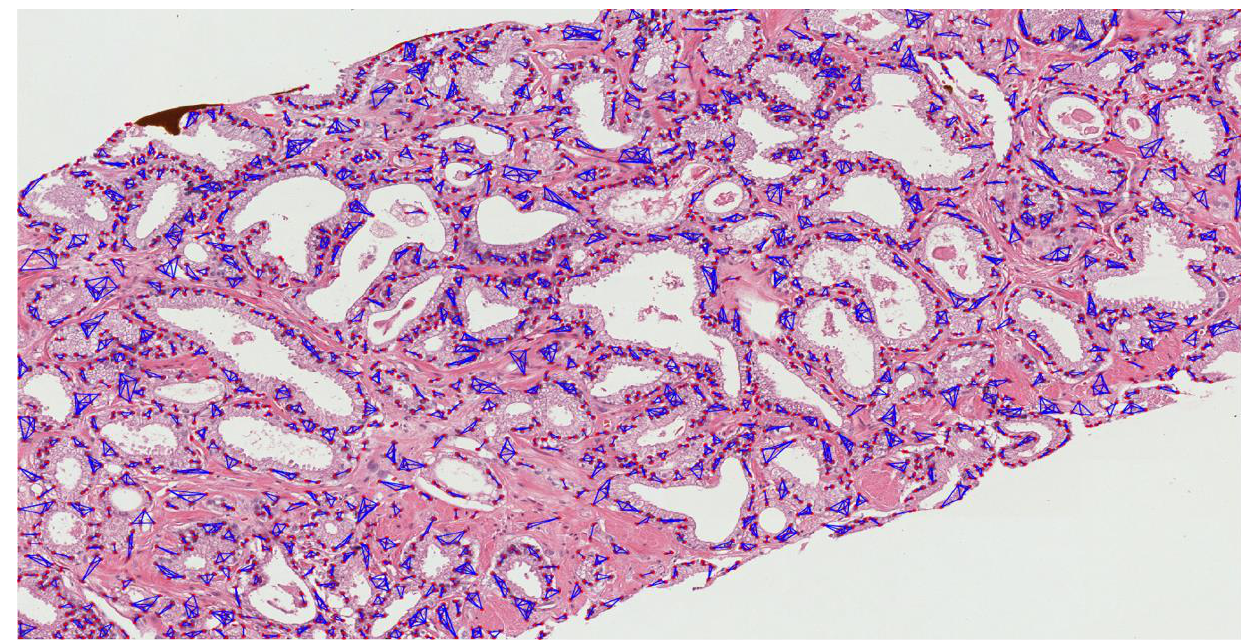
Figure A4. The proliferation and community structure of cell nuclei in the annotated region of grade 3.